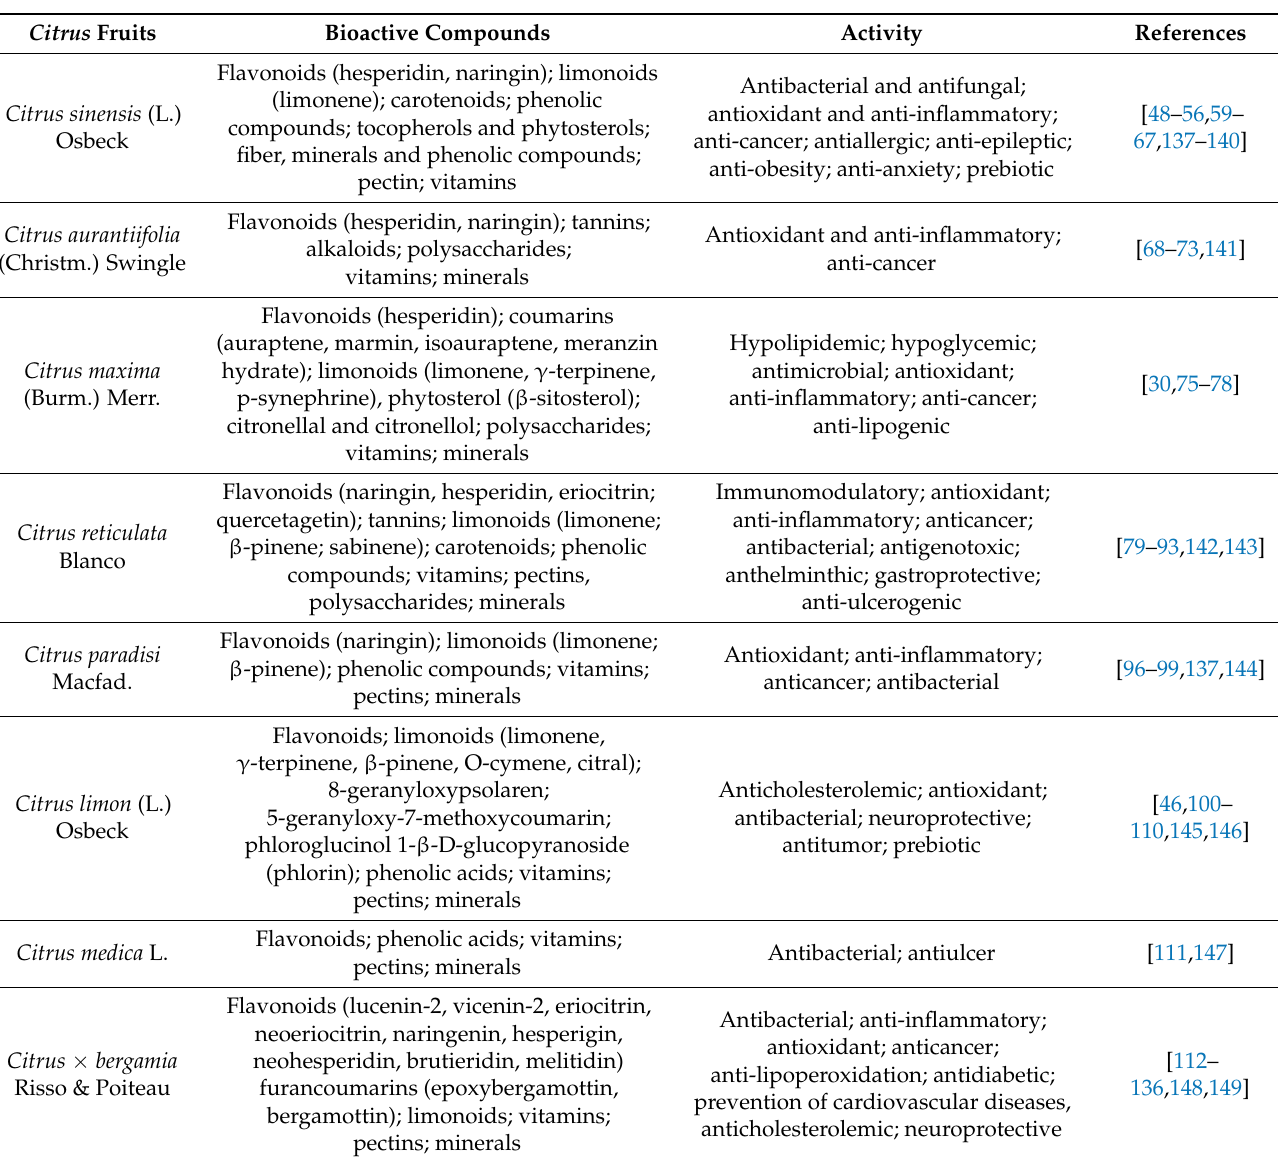
Table 1. Main bioactive compounds contained in Citrus by-products and their pharmacological